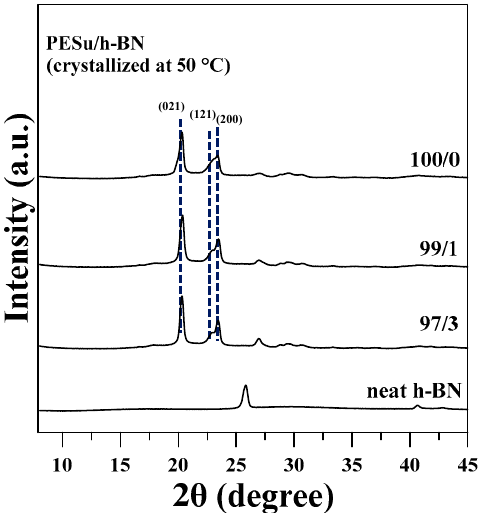
Figure 10. XRD patterns of the neat PESu, neat h ‐ BN, and PESu/h ‐ BN composites. Neat PESu and the PESu/h ‐ BN composites were crystallized at 50 °C.